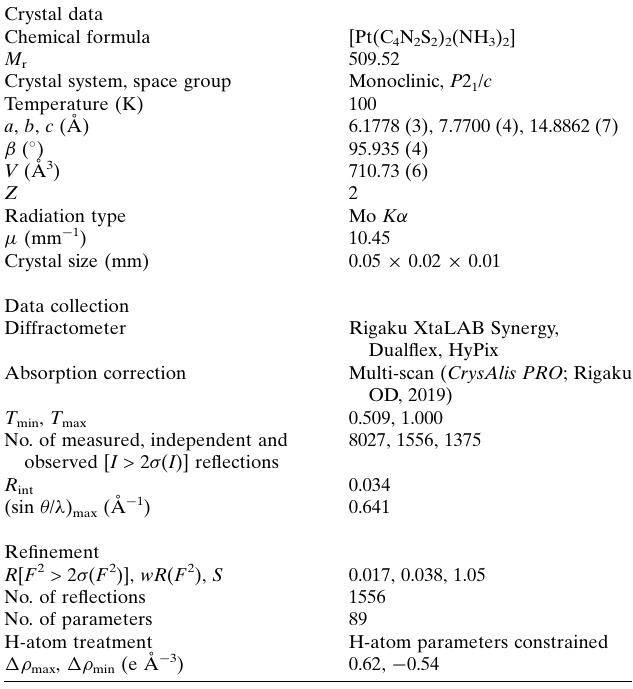
Table 2 Experimental details. Crystal data Chemical formula